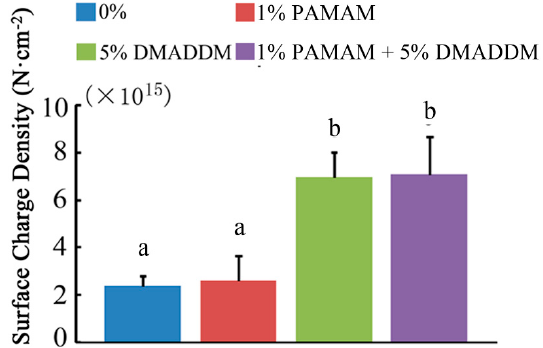
Figure 2. Surface charge density of the cured disks in four groups. Bars with the same letter indicate values that have no significant difference ( p > 0.1) and those with the dissimilar letters indicate significant difference ( p < 0.05).